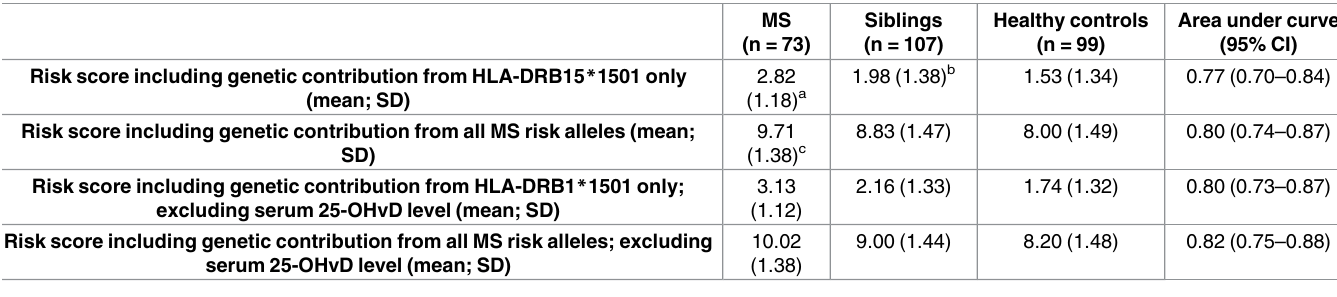
MS Healthy controls Area under curve (n = 73) (n = 99) (95% CI)